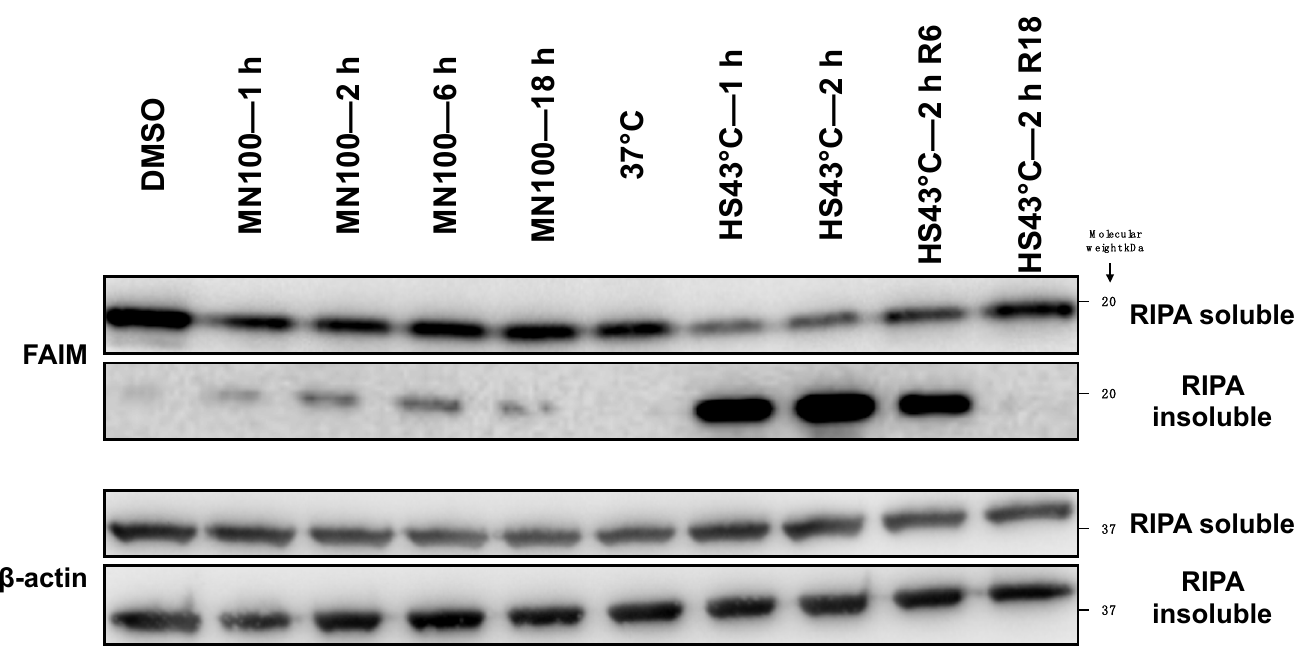
Figure 2. FAIM protein shifts to the detergent-insoluble fraction after stress induction. HeLa cells were exposed to heat shock (HS) at 43 °C for 1 h or for 2 h and were incubated at 37 °C for 6 or 18 h recovery (R6 and R18) after incubation at 43 °C for 2 h, as indicated. HeLa cells were also subjected to oxidative stress by treatment with 100 μ M menadione (MN) for the indicated times (vehicle control; DMSO for 18 h). After stress induction, cells were harvested, soluble proteins were isolated using RIPA buffer and RIPA buffer-insoluble proteins were extracted. Equal amounts of protein for each fraction were analyzed by Western blotting for FAIM, and for actin as a loading control. Data representative of 3 independent experiments are shown.